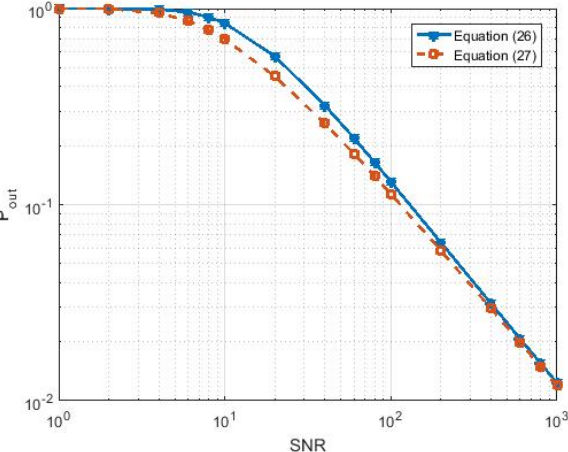
Figure 3. The optimal outage probability comparison of (26) and (27) with different SNR.